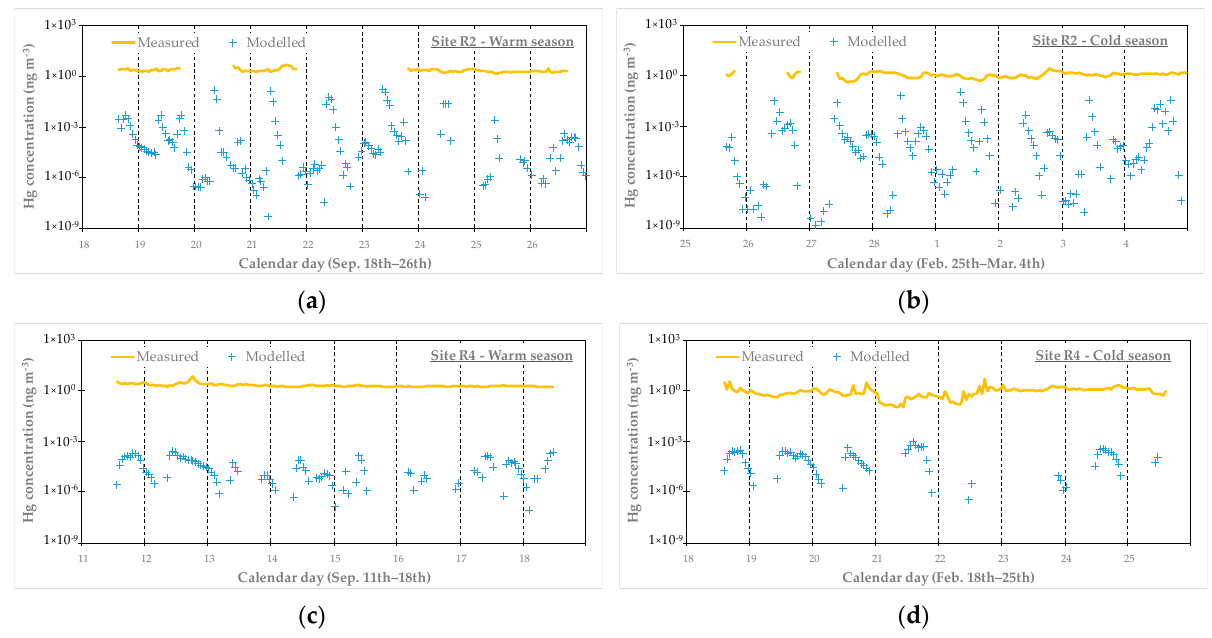
Figure 7. Time patterns of measured and modelled 1 h concentration of mercury (ng m − 3 ) at site R2 (( a ): warm season; ( b ): cold season) and R4 (( c ): warm season; ( d ): cold season).